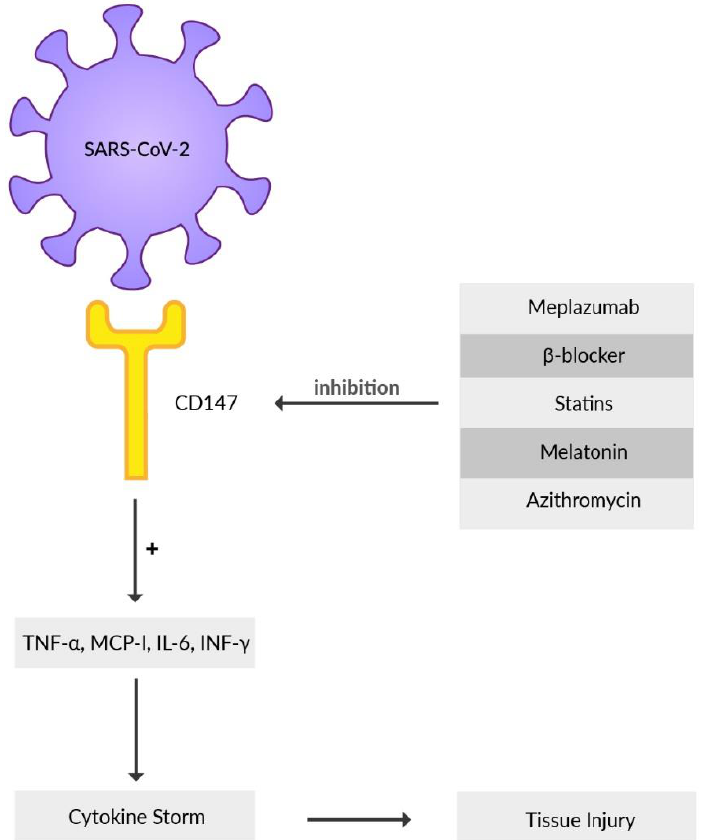
Figure 3. CD147-mediated signaling pathway. The serum cytokine increase (TNF- α , MCP-1, IL-6, and INF- γ ) contributes to the cytokine storm in the host organism. CD147 inhibitors prevent SARS-CoV-2 entry into the host cell.